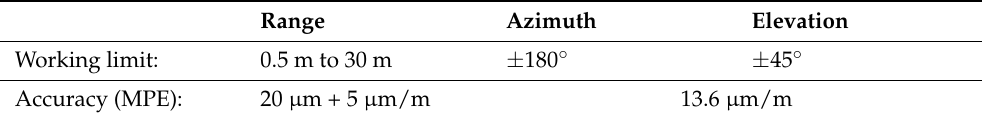
Table 2. APDIS laser radar MV430E working limit and accuracy performance measures.